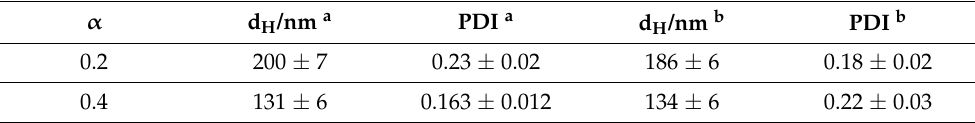
Table 5. Hydrodynamic diameter, d H , and polydispersity, PDI, of (TEAC 12 ) 4 /DOPE liposomes and doxorubicin loaded (TEAC 12 ) 4 /DOPE liposomes. T = 310 K. The results are the average of three independent